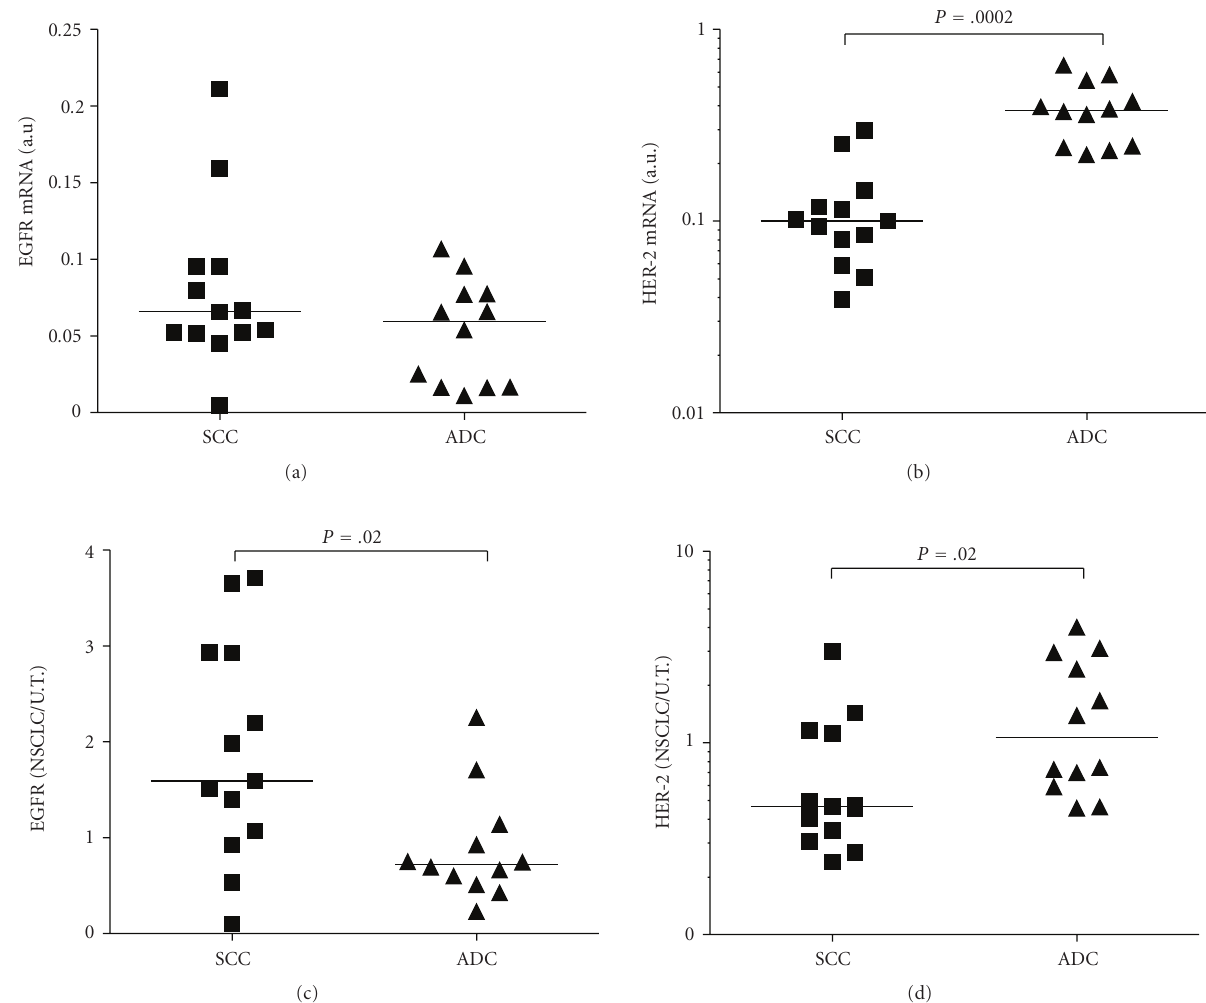
Figure 1: (a) EGFR and HER-2 transcript levels (as arbitrary units, a.u.) in squamocellular carcinoma (SCC) and adenocarcinoma (ADC) samples. Lines represent medians of values. (b) Expression ratio levels of the same genes in the cancerous (C.T.) versus una ff ected tissues (U.T.). Lines represent medians of